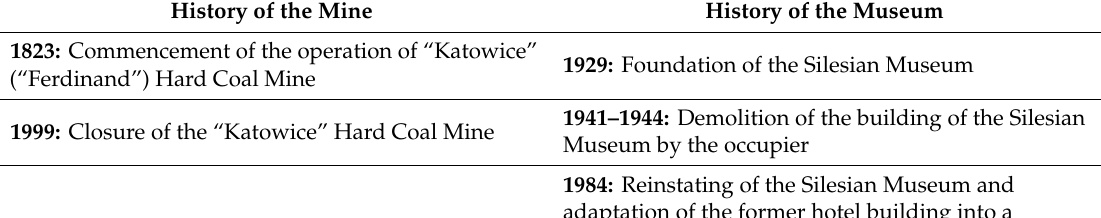
Table 1. History of the Katowice Hard Coal Mine and Silesian Museum (source: Own